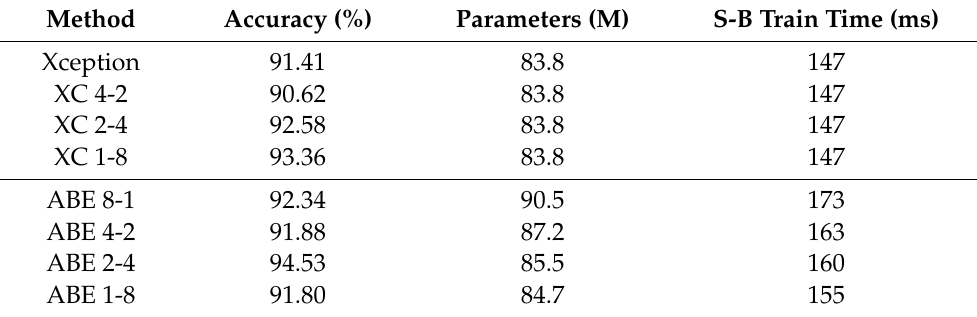
Figure 7. The Grad-CAM visualization results of 8 models. We compare Xception with 7 other models to see how different widths and depths affected the model’s performance, and how the attention module fits the widths and depths of the backbone. Table 6. Comparison of accuracy, number of parameters and single batch training time of the 8 networks on Trashnet